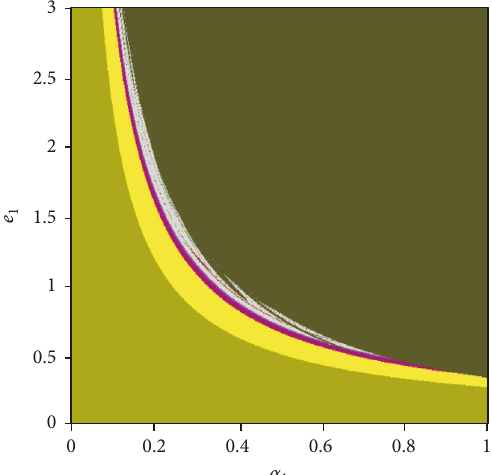
Figure 6: (𝑒 1 ,𝛼) -2D bifurcation diagram with 𝛽 = 0.3 and 𝛾 = 0.1 .